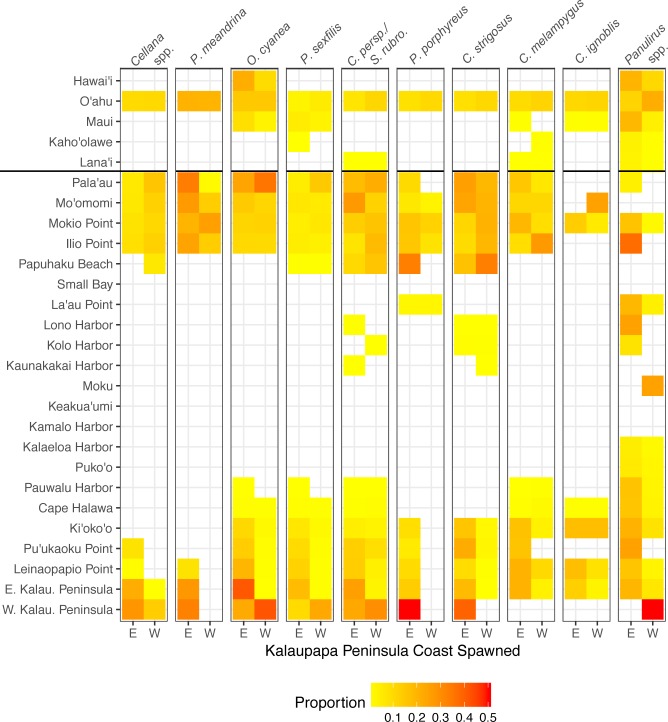
Connectivity matrix for larvae spawned on Kalaupapa Peninsula.Includes larvae settled on Molokaí (regions below horizontal black line) and those settled on other islands (regions above horizontal black line), spawned from either the east (E) or west (W) coast of Kalaupapa. Heatmap colors represent rearward proportion, calculated by the number of larvae settling at site s from site o divided by all settled larvae at site s. White squares indicate no dispersal along this path.